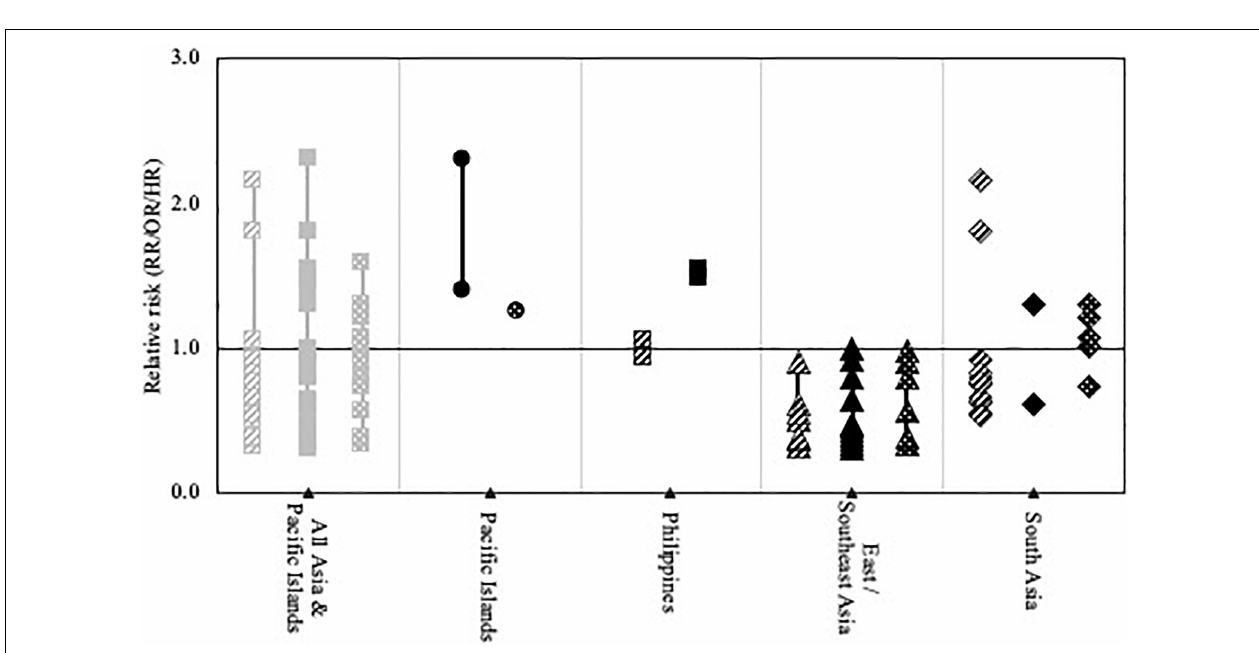
FIGURE 1 | Visual representation of point estimates for relative GH and PE risk reported in the included studies among different racial and ethnic groups compared to non-Hispanic White women. Non-Hispanic Black, African American or Black women; Latina or Hispanic women; Asian or Pacific Islander women; North African or Middle Eastern women (NA/ME); × American Indian/Alaska Native women; + Aboriginal/Torres Strait Islander or Maori women; living in Europe; living in the US; living in South Africa; living in another predominantly White country. Study quality and precision of the estimates were not accounted for in the figure, and it should thus be interpreted as an overview of the available evidence, not as a formal statistical summary.